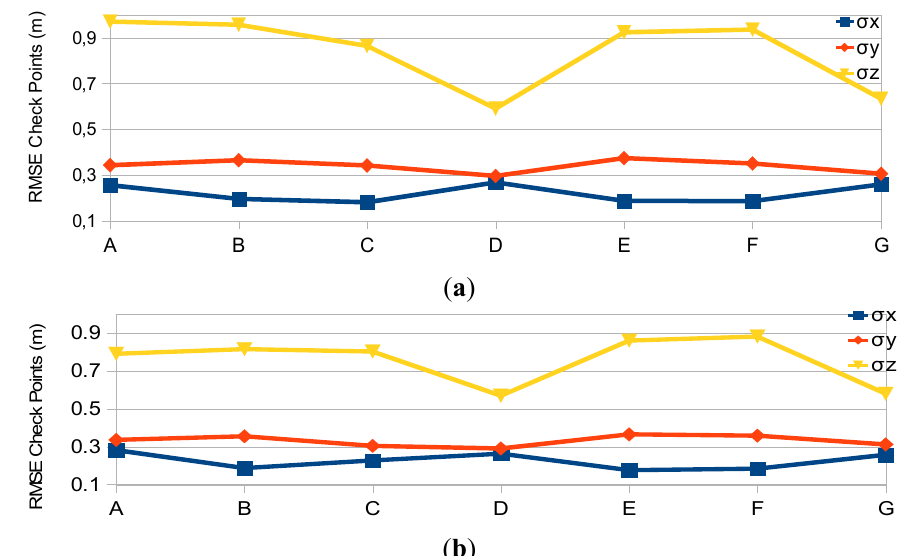
Figure 12. RMSE in the check points coordinates obtained in a bundle adjustment with three virtual images generated with parameters obtained in the experiments: ( a ) without and ( b ) with scale correction in the right